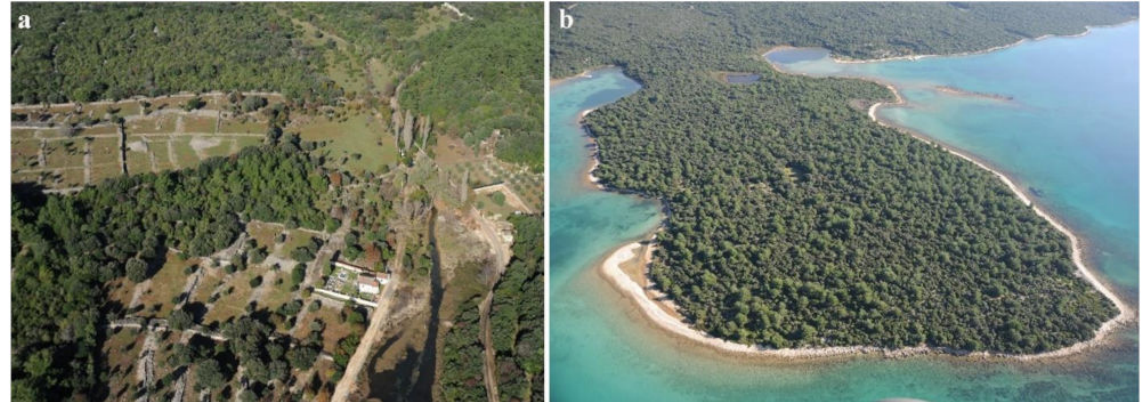
Figure 3. Oblique aerial photographs. ( a ) Active agricultural area near Sv. Andrija with olive groves and maintained dry stone walled agricultural fields. ( b ) Disused agricultural area near Sv. Platon covered by maquis. (Photographs: M.